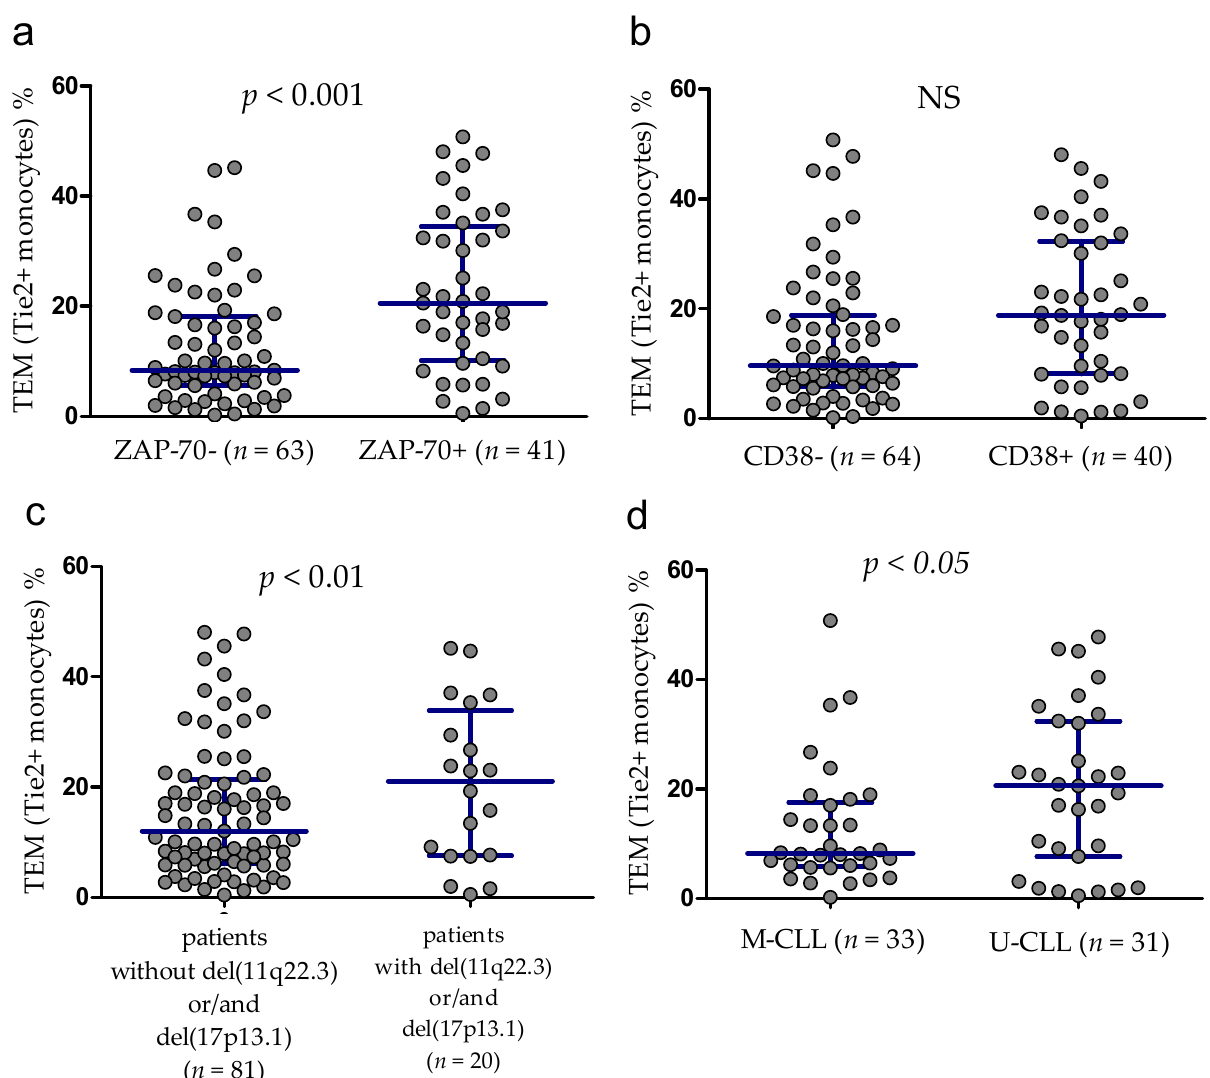
Figure 3. Tie2+ monocytes (TEM) percentage and adverse prognostic factors. ( a ) ZAP-70+ and ZAP-70 − patients and ( b ) CD38+ and CD38 − ones. ( c ) TEM percentage in CLL patients carrying the unfavorable cytogenetic changes and patients without adverse aberrations. ( d ) Tie2+ monocytes in patients harboring different status of IGHV mutation. Scatter plots present raw data. The central line shows the median. “Whiskers” represent IQR. IGHV mutational status was accessible for 64 participants of this study. U-CLL, IGHV-unmutated; M-CLL, IGHV-mutated, IQR, interquartile range.